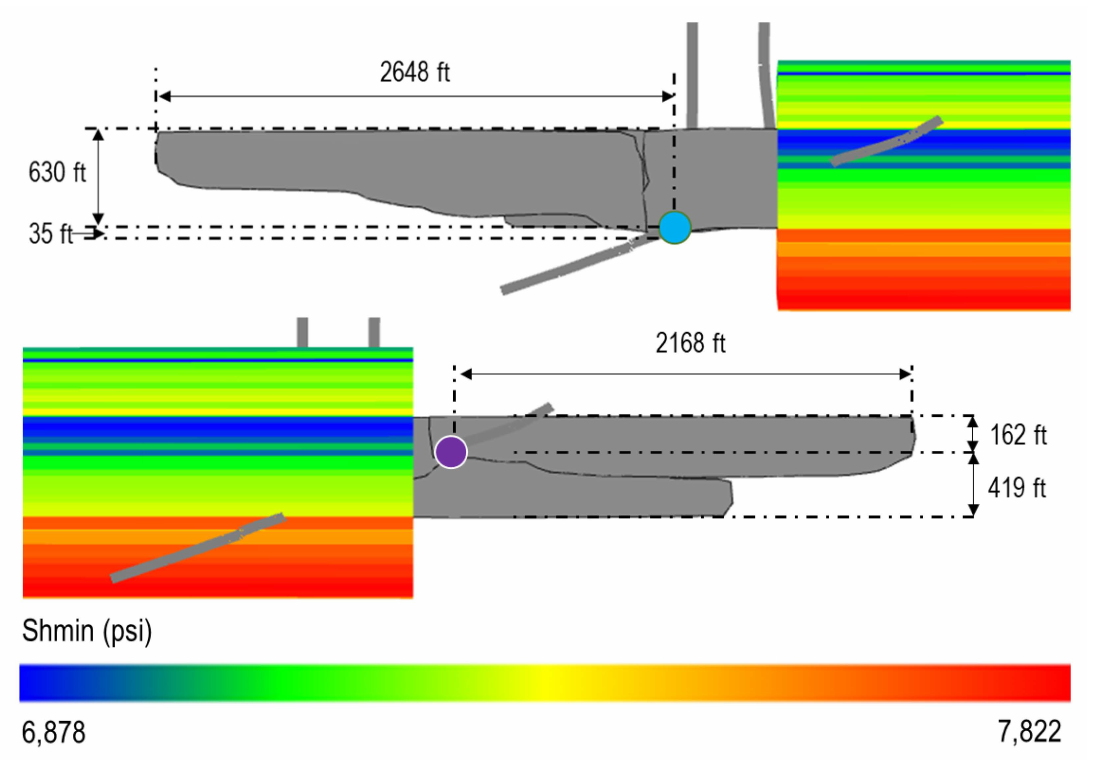
Figure 24. Fracture geometry predicted from numerical simulations for the anisotropic stress profile, in bleu Well #1, in purple Well #2.